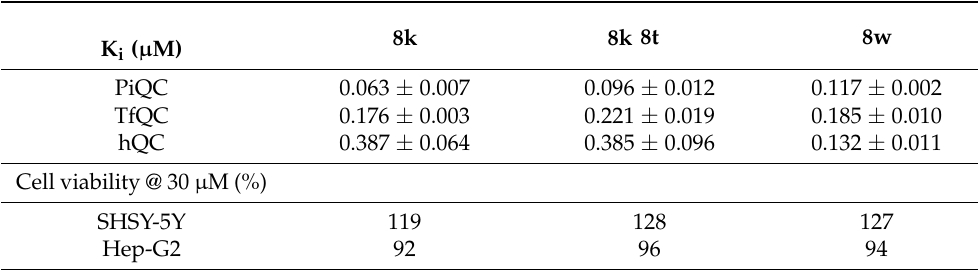
Table 3. Inhibition of related glutaminyl cyclases from bacteria and human and cytotoxicity of selected